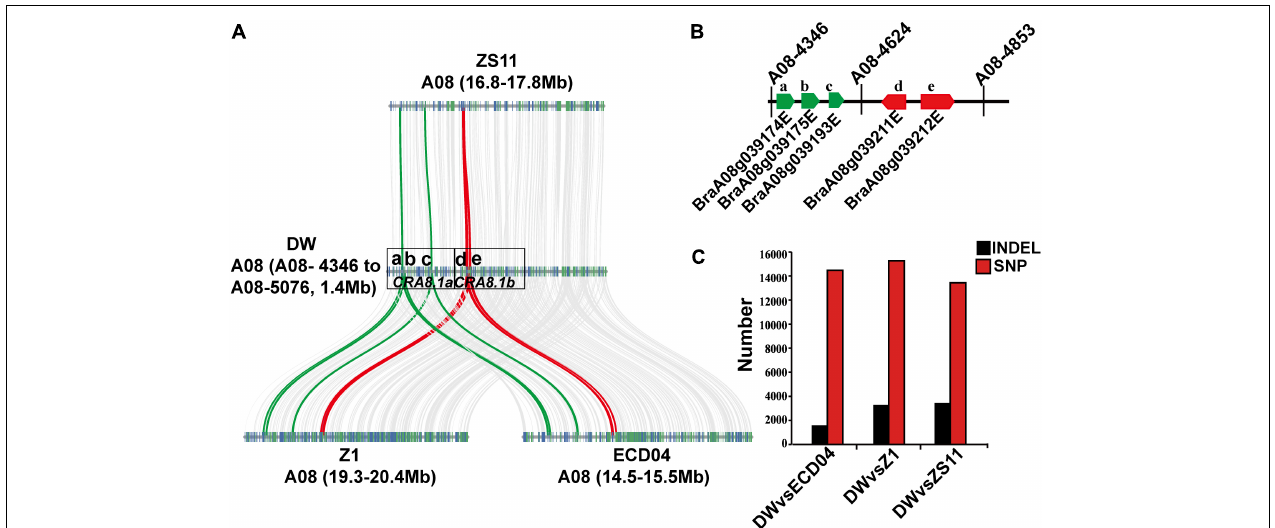
FIGURE 4 | Genome structure comparison between homologous regions on A08 chromosome from DW, HZSX (Z1), ECD04, and ZS11. (A) Gene synteny analysis between chromosomal regions from A08-4346 to A08-5076 on A08 chromosome from DW, ECD04, ZS11, and Z1. a–e represent five candidate R genes found within this region. a–c belongs to the CRA8.1a region. d, e belongs to the CRA8.1b region. (B) Genomic orientation of the five candidate R genes between A08-4346 and A08-4853 on A08 chromosome. Green and red bars represent the candidate genes in CRA8.1a and CRA8.1b loci, respectively. (C) Number of SNPs and InDels in DW compared with ECD04, Z1, and ZS11 between the target regions flanked by markers of A08-4346 and